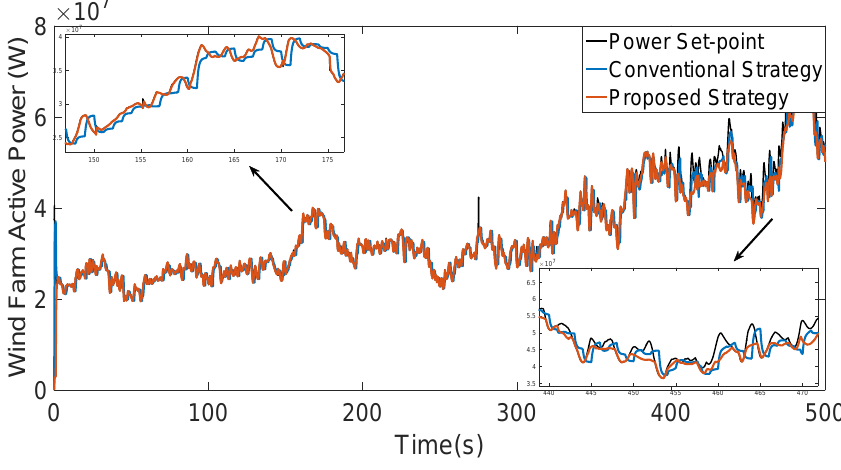
Figure 11. Frequency-domain aggregation for cluster